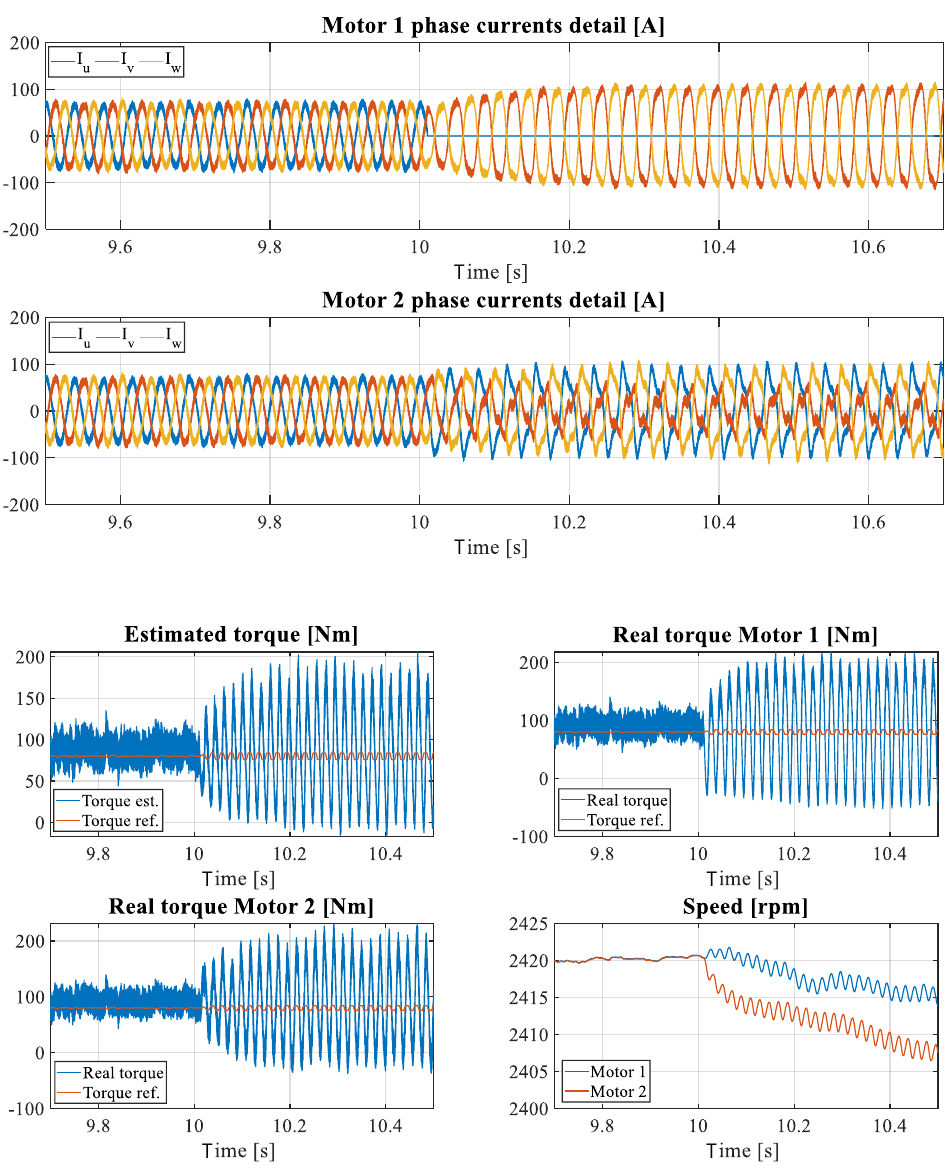
Figure 6. Phase currents of motor 1 and motor 2 at 2400 rpm and 50 Nm load (open-phase fault at t = 10